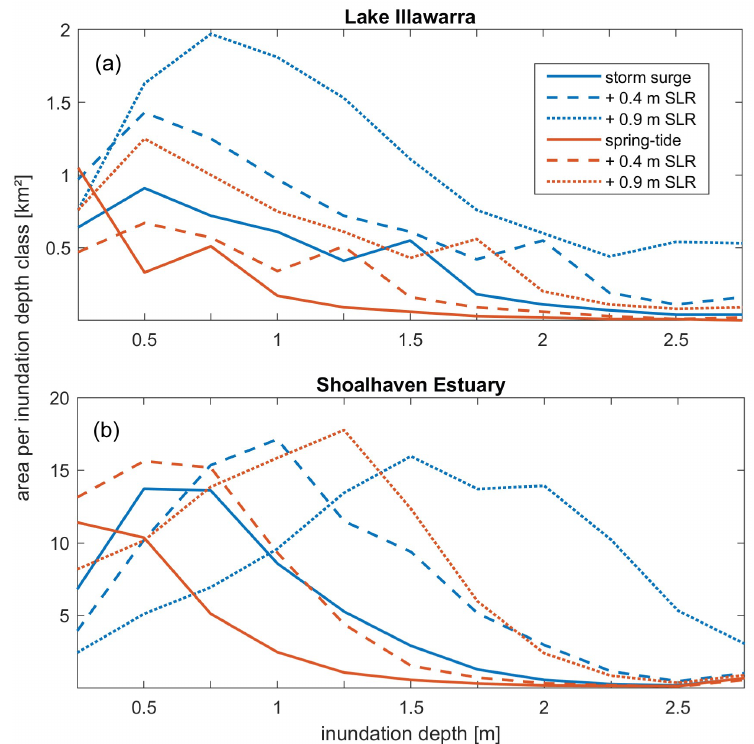
Figure 3. Distribution of maximum inundation depths in 0.25 m intervals across the floodplain of Lake Illawarra ( a ) and the Shoalhaven Estuary ( b ) for simulations of spring-tide (red) and storm surge (blue) in combination with present sea level as well as SLR of +0.4 m and +0.9 m. Note the difference in vertical scale due to the different size of the floodplains.